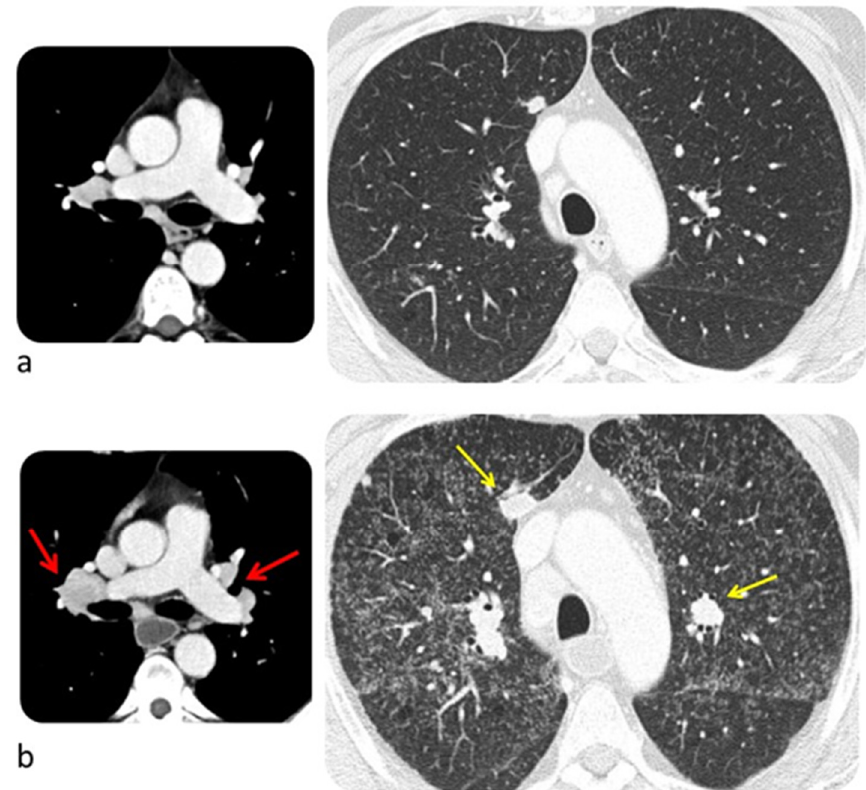
Figure 6. Sarcoid-like post immunotherapy granulomatosis in a 48-year-old man with metastatic melanoma. CT scan was performed before starting pembrolizumab ( a ) and two months later ( b ). The latter shows appearance of disseminated small nodules similar in size, enlarged hilar and mediastinal lymph nodes (red arrow), and progressive disease (yellow arrow). © Department of Radiology, Candiolo Cancer Institute—IRCCS. Turin.